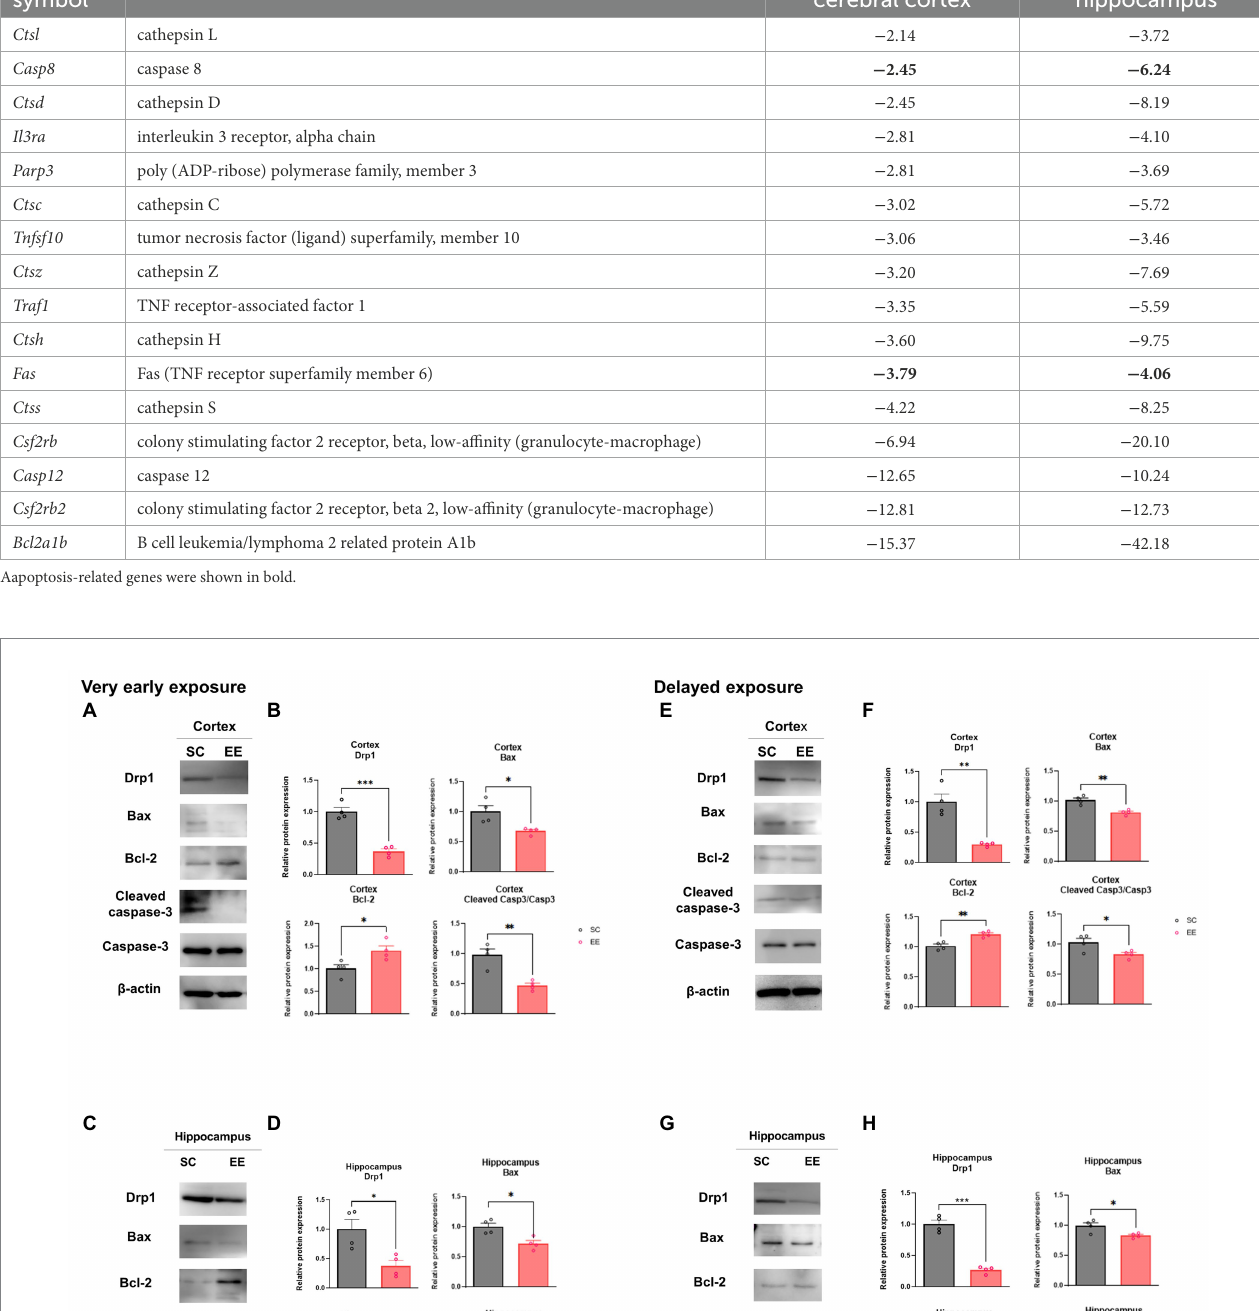
TABLE 2 List of genes downregulated in the cerebral cortex and the hippocampus in response to very early exposure to EE after hypoxic–ischemic brain injury. Gene